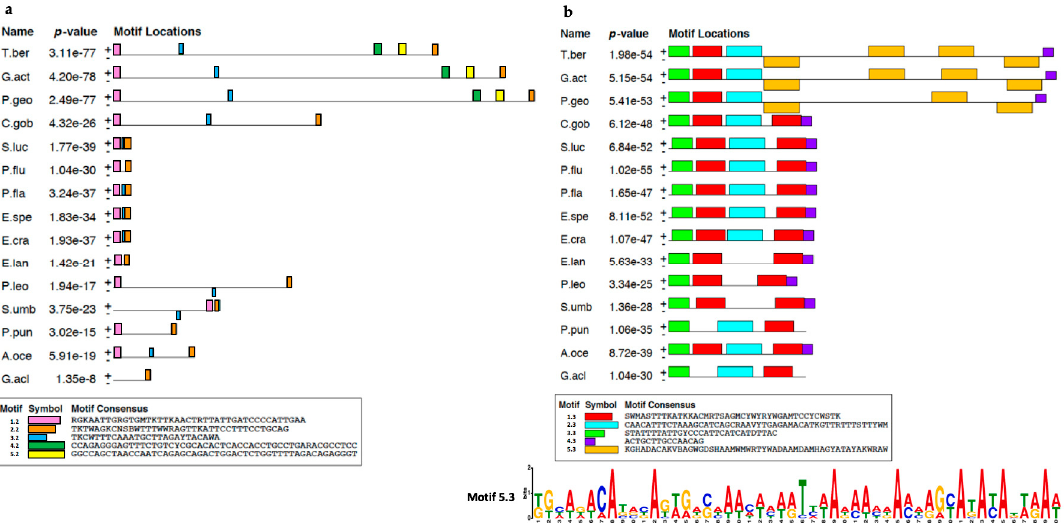
Figure 1. Conserved sequence motifs (colored boxes) identified by MEME in the second ( a ) and third introns ( b ) of pIgR from Trematomus bernacchii (T.ber), Gymnodraco acuticeps (G.act), Pseudochaennichthys georgianus (P.geo), Cottoperca gobio (C.gob), Sander lucioperca (S.luc), Perca fluviatilis (P.flu), Perca flavesvens (P.fla), Etheostoma spectabile (E.spe), Etheostoma cragini (E.cra), Epinephelus lanceolatus (E.lan), Plectropomus leopardus (P.leo), Sebastes umbrosus (S.umb), Pungitius pungitius (P.pun), Anarrhichthys ocellatus (A.oce), and Gasterosteus aculeatus (G.acl). The WebLogo representation of motif 5.3 (ocher box) is reported at the bottom of panel ( b ).